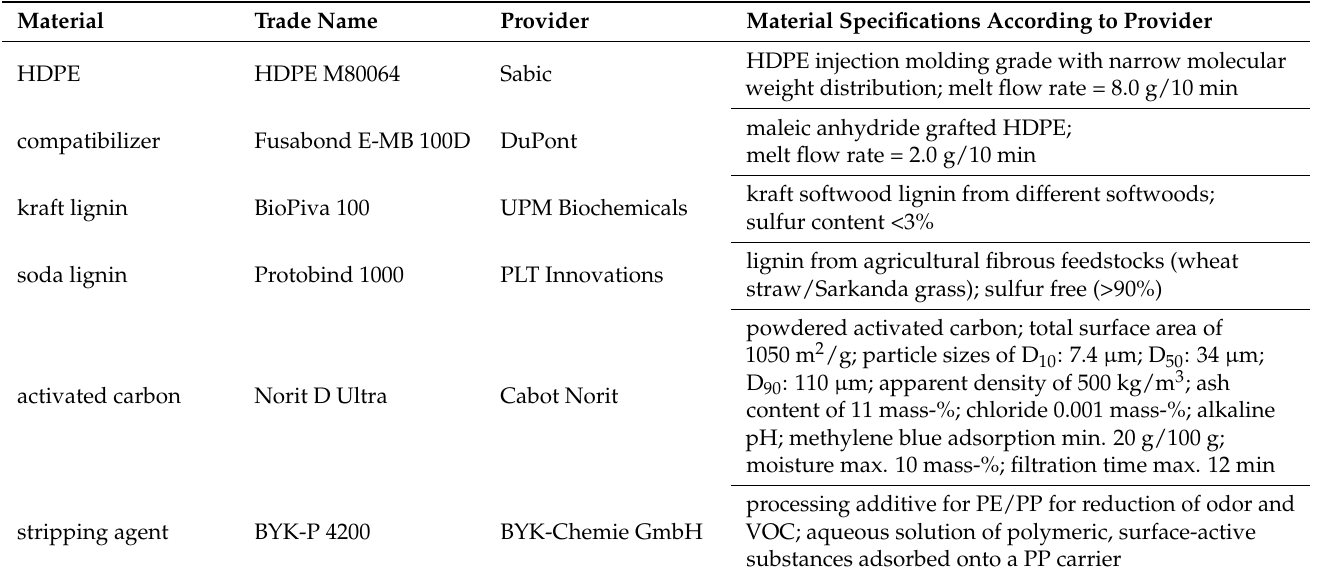
Table 1. Materials and corresponding properties used for the production of the HDPE-lignin